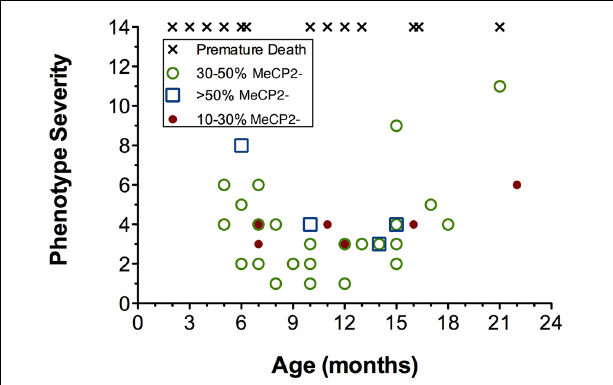
FIGURE 8 | Age, phenotype severity and XCI ratios are not correlated in Mecp2 + / − mice. Increasing age is not a predictor of phenotype severity of Mecp2 + / − mice. Aged Mecp2 + / − animals are not more likely to have highly skewed XCI ratios (10–30% mutant neurons, red circles) and XCI ratios do not predict phenotype severity at any age. Premature death (x’s) occurred across both young and old age groups. A premature death is defined as any animal that died spontaneously (not sacrificed for experiments), therefore XCI ratios were unavailable.